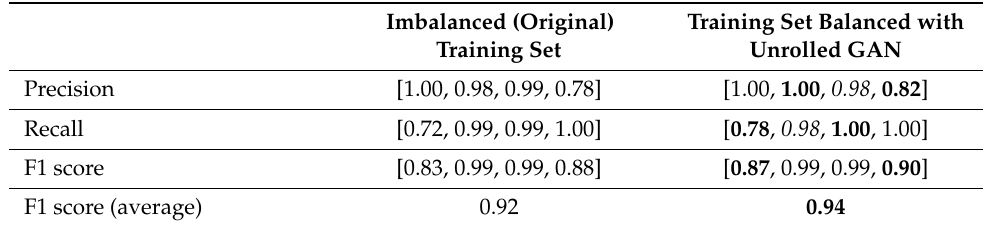
Table 3. The effect of training set augmentation for the CinCECGTorso data (the precision, recall, and F1-score values are ordered by class).